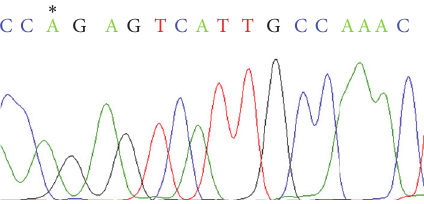
Figure 3: The DNA sequence showed the replacement of guanine to adenine with an asterisk symbol. Replacement of guanine with adenine generated by the activity of the terminal deoxynucleotidyl transferase of Taq polymerase was detected by DNA sequencing